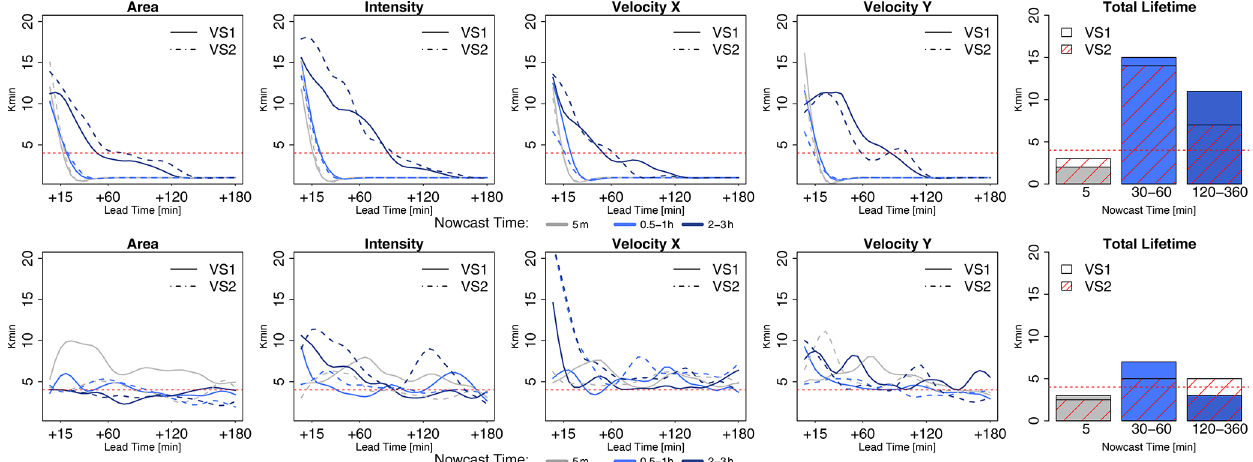
Figure 8. The optimization of the k -NN per target variable based on predictors and weights derived from Pearson correlation analysis: the median optimal selected “ k ” neighbours yielding the lowest absolute errors over the 110 events. Two k -NN applications are shown here – VS1 in solid line and VS2 in dashed line. First row – the optimal neighbour is found by minimizing the MAE for a given group of nowcast times per event. Second row – the optimal neighbour is found by minimizing the MAE for the given group of nowcast times per event. The red dashed horizontal line indicates the k = 4 that is chosen in this study for the deterministic k -NN application.